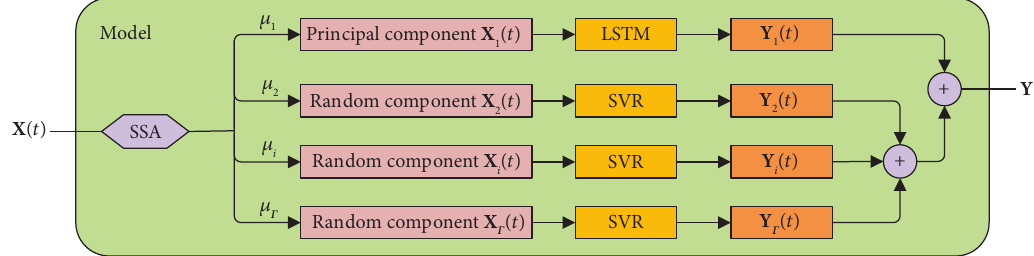
Figure 2: SSA-LSTM-SVR.